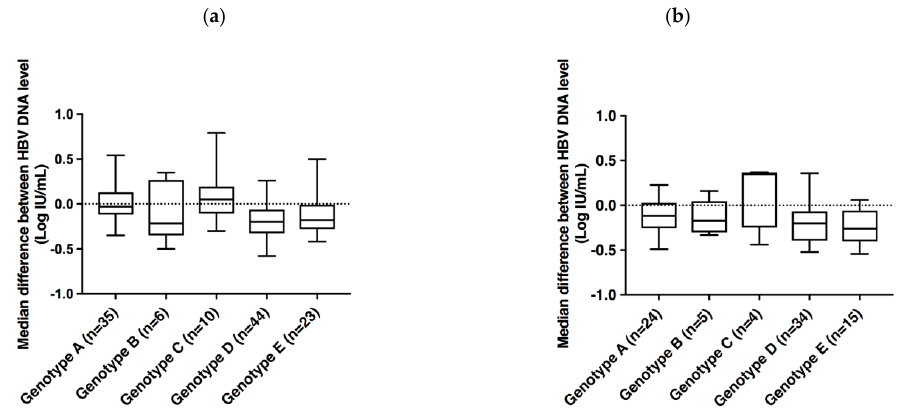
Figure 3. Box plot representation of the distribution of the median differences between HBV DNA levels measured by the cobas ® HBV Test and CAP/CTM HBV Test v2.0 ( a ) or Alinity™ m HBV assay ( b ).